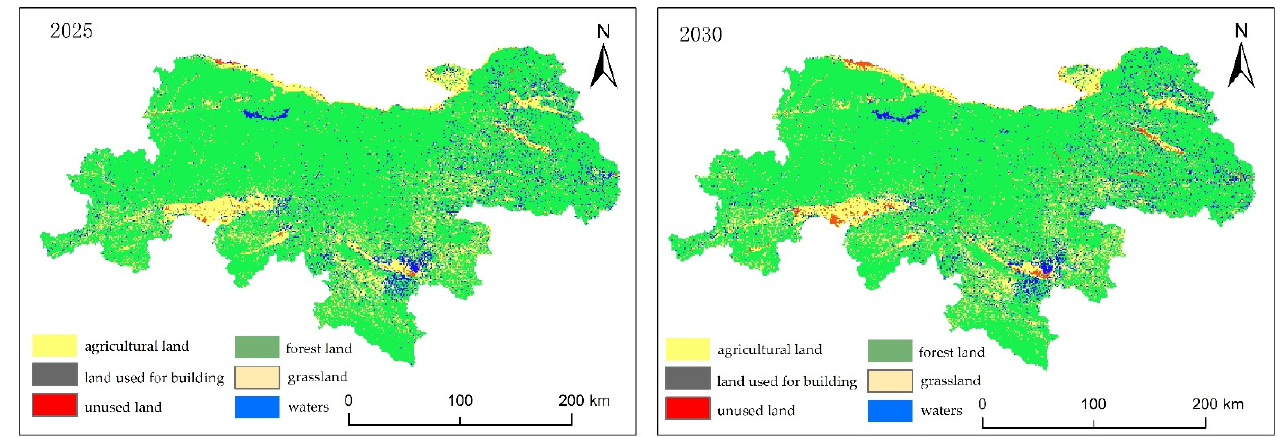
Figure 7. Land-use types in 2025 and 2030. Table 5. Land-use type area.